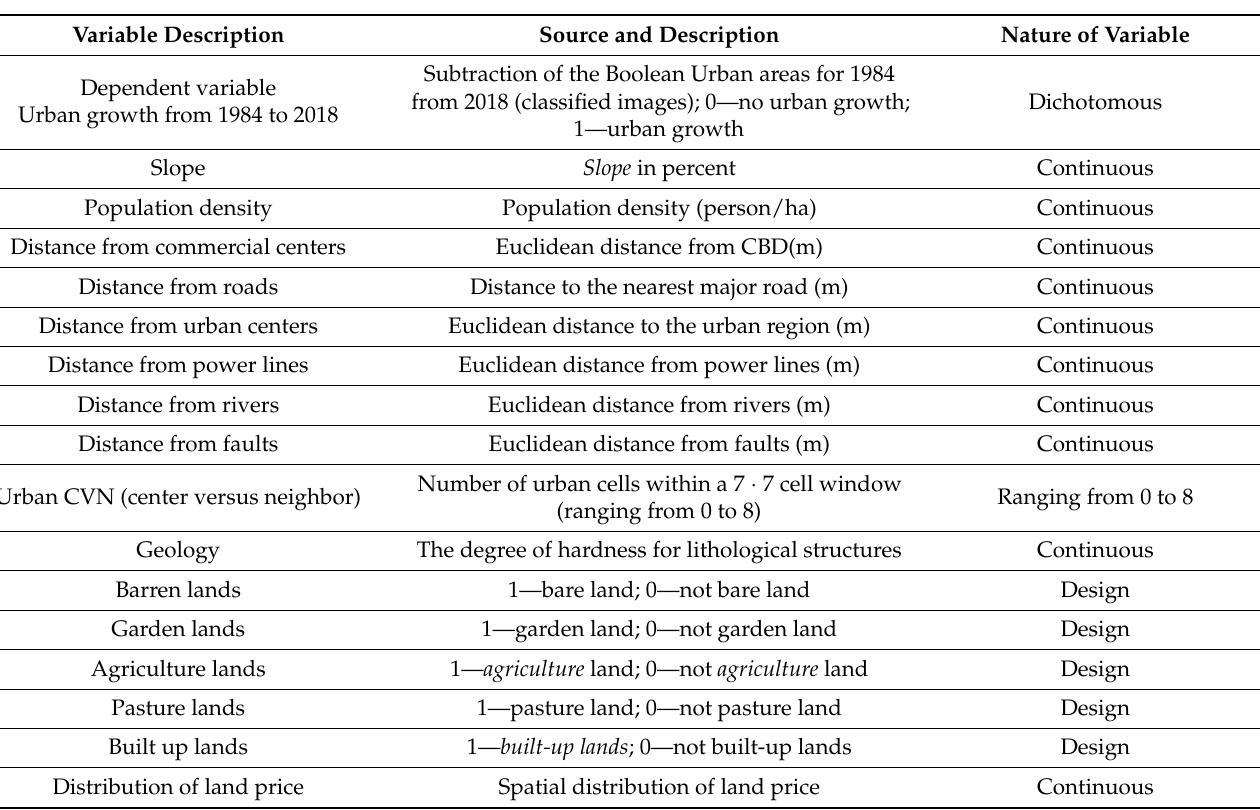
Table 4. List of variables as inputs for logistic regression and